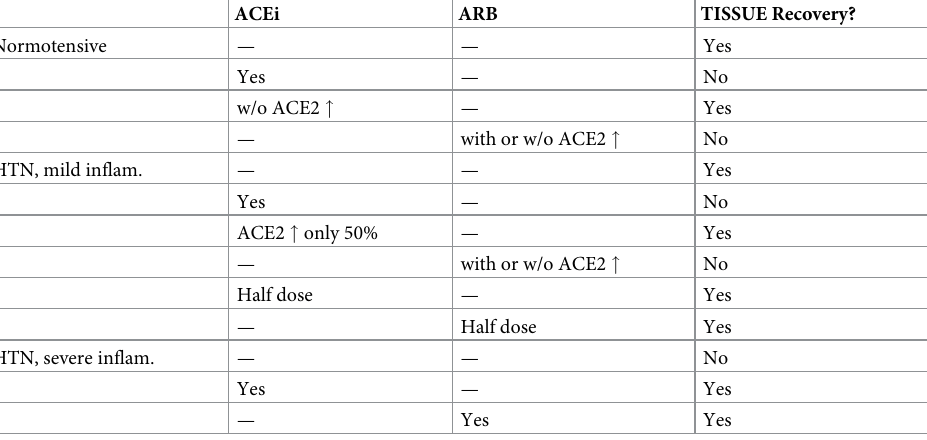
Table 1. Simulated COVID-19 outcome for normotensive patients, hypertensive (HTN) patients with an existing mild inflammation, and HTN patients with a more severe inflammation. ACEi, angiotensin-converting enzyme inhibitor ARB, angiotensin II receptor blocker. In the “ACEi” column, “Yes” corresponds to full effect of ACEi, i.e., reduced conversion rate from Ang I to Ang II and upregulation of ACE2; “w/o ACE2 " ” and “ACE2 " only 50%” repre- sent only the reduced Ang I-to-Ang II conversion rate, with ACE2 level kept at baseline or 2.5-fold increase, respec- tively; “Half dose” represents half the ACEi effect, in both Ang I-to-Ang II conversion and ACE2 upregulation. Labels under the “ARB” column are defined